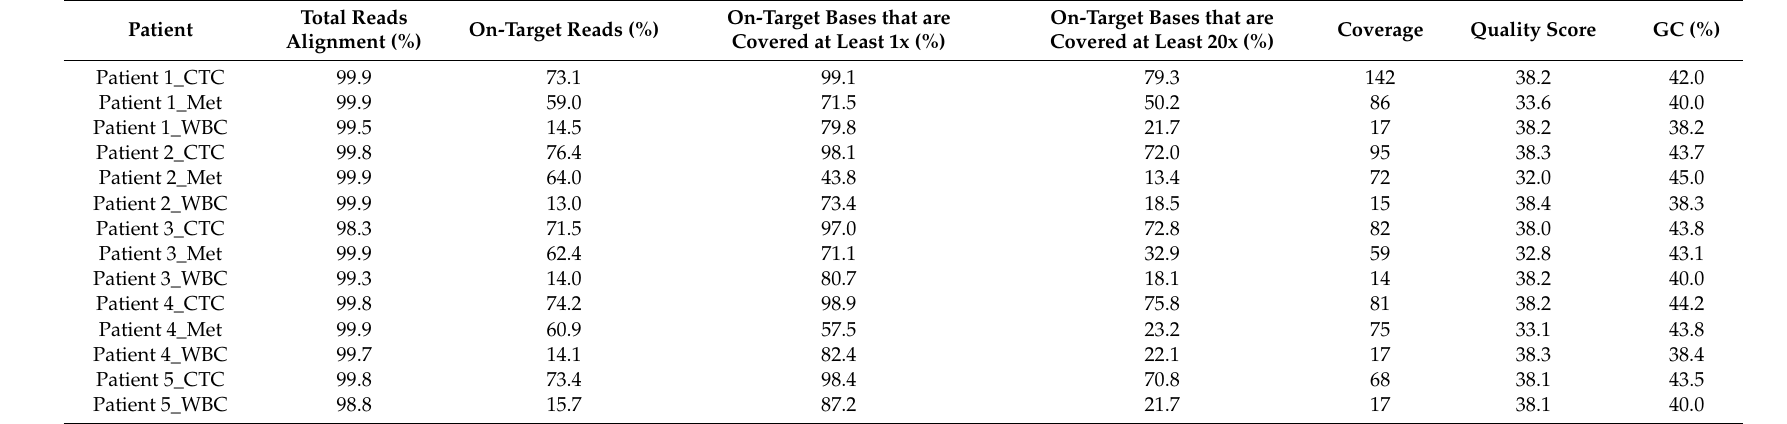
Table 2. Summary of sequencing and alignment statistics across all clinical